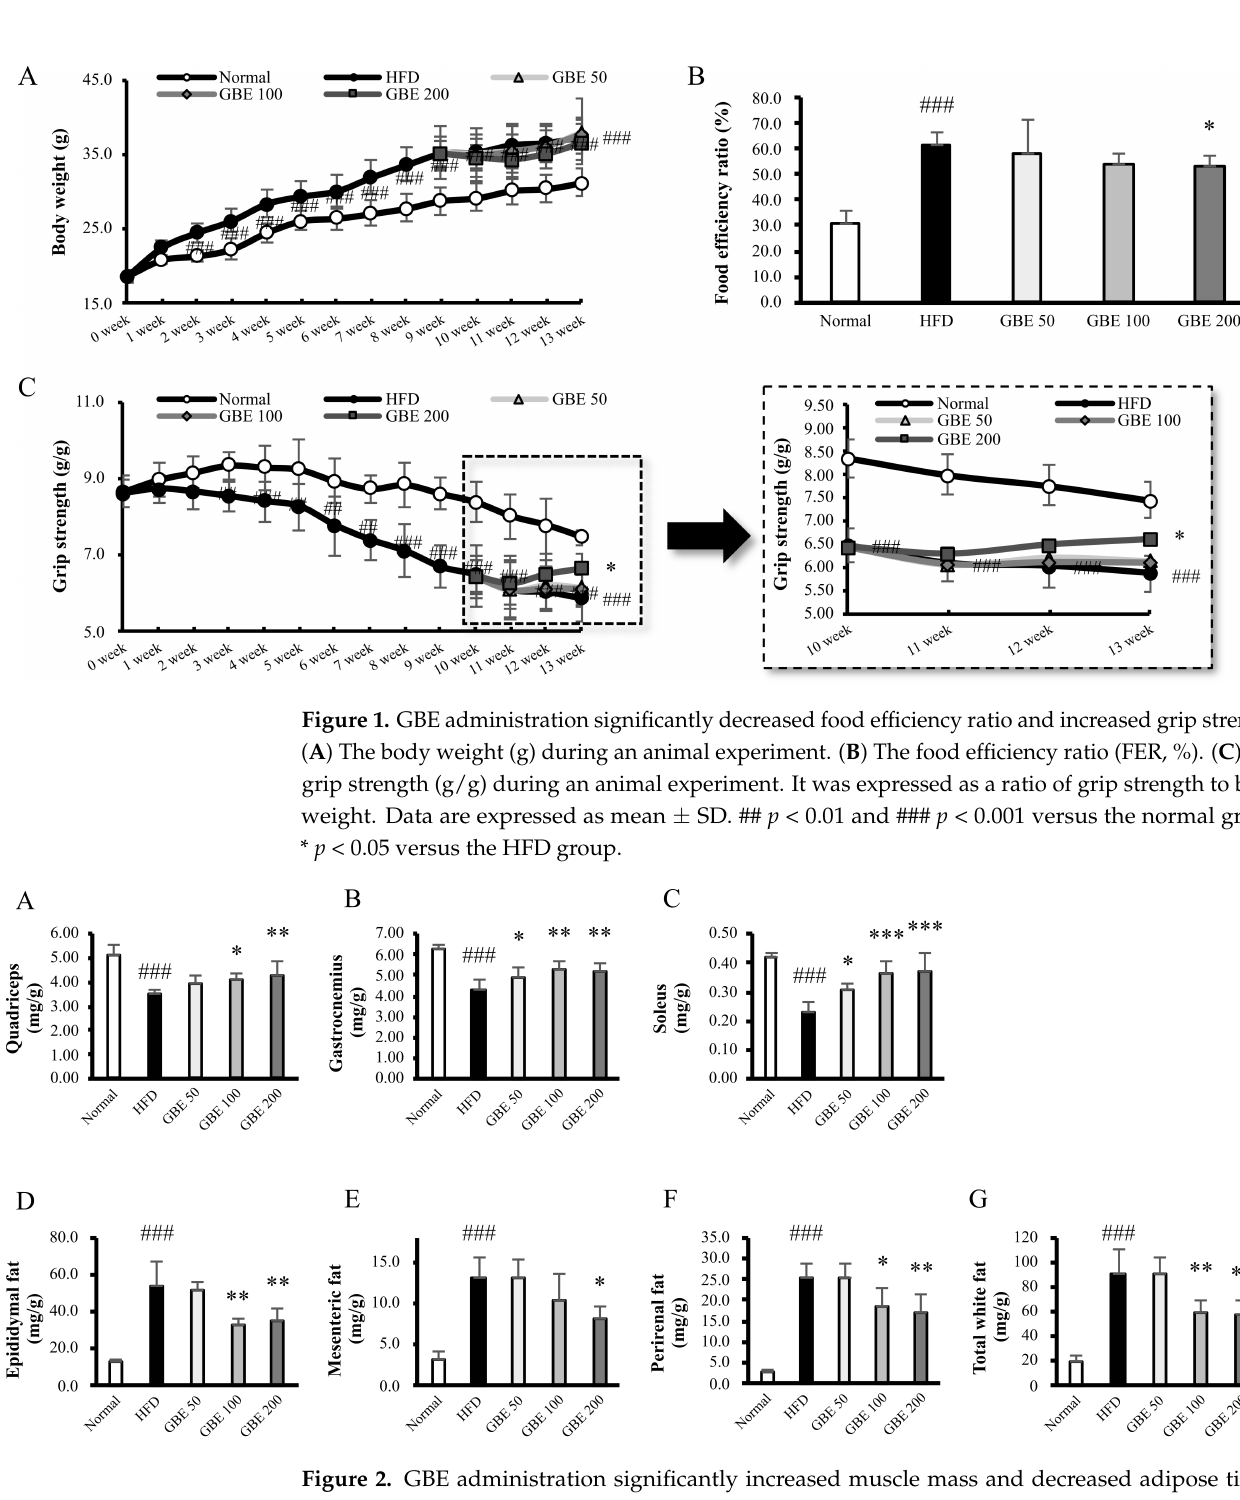
Figure 2. GBE administration significantly increased muscle mass and decreased adipose tissue weights. The muscle mass: ( A ) quadriceps, ( B ) gastrocnemius, and ( C ) soleus. They were expressed as a ratio of muscle tissue weight to body weight (mg/g). The adipose tissue weights: ( D ) epididymal fat, ( E ) mesenteric fat, ( F ) perirenal fat, and ( G ) total white fat. The total white fat was calculated, adding the three fat weights. They were shown as a ratio of fat weight to body weight (mg/g). Data are expressed as mean ± SD. ### p < 0.001 versus the normal group. * p < 0.05, ** p < 0.01, and *** p < 0.001 versus the HFD